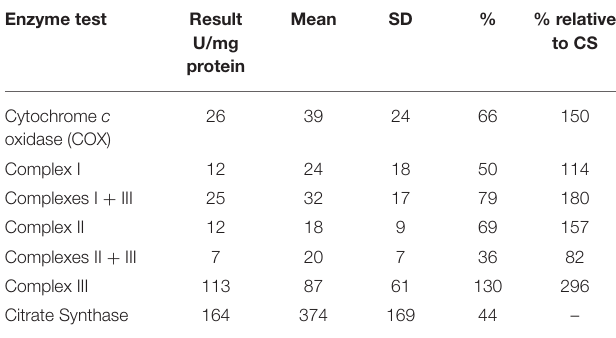
FIGURE 1 | Muscle biopsy ultrastructure demonstrating intra-mitochondrial globular inclusions (arrows) (15,000 X).